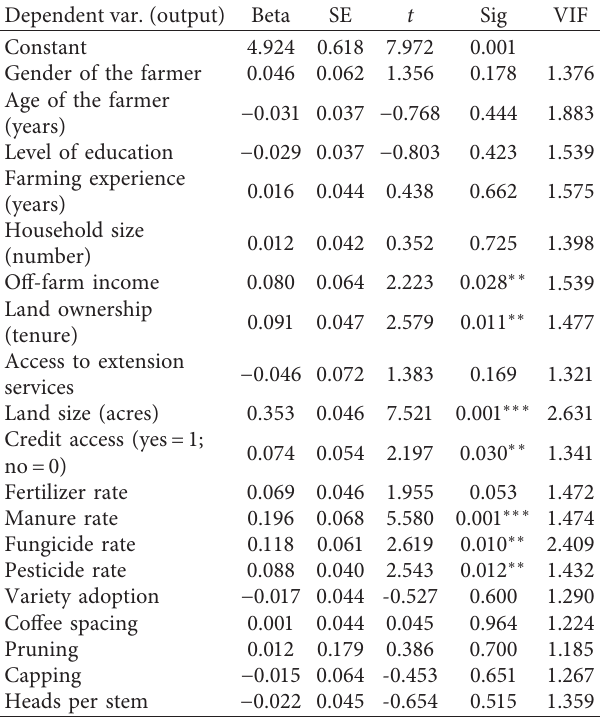
Table 6: Multiple regression for socioeconomic and technical factors affecting coffee